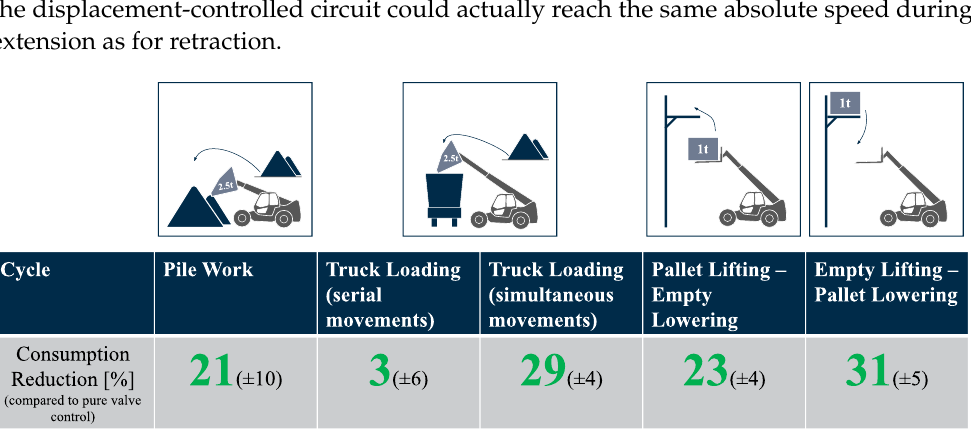
Figure 8. Consumption reduction of the partially displacement-controlled setup and its deviation, compared to the purely valve-controlled but also electrified reference setup and for the five considered cycle types (see Equations (13) and